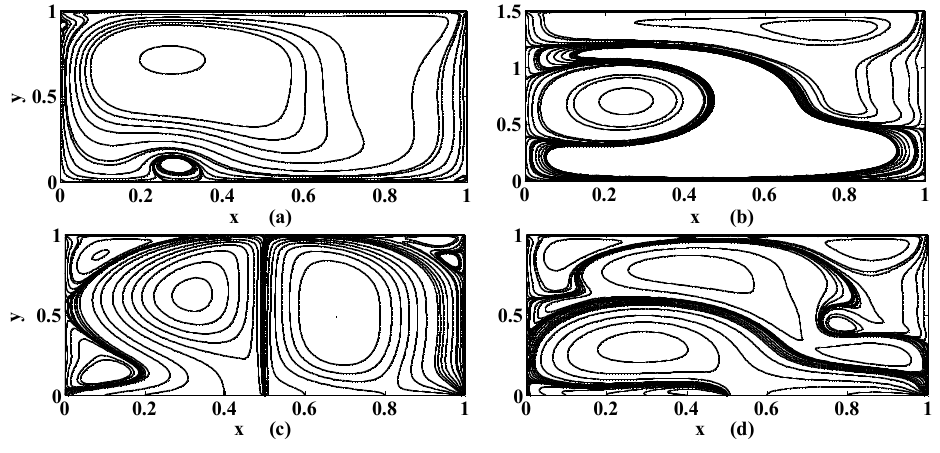
(cid:110) (cid:111) α γ = { 0, 0.5 } ; ( b ) p ,